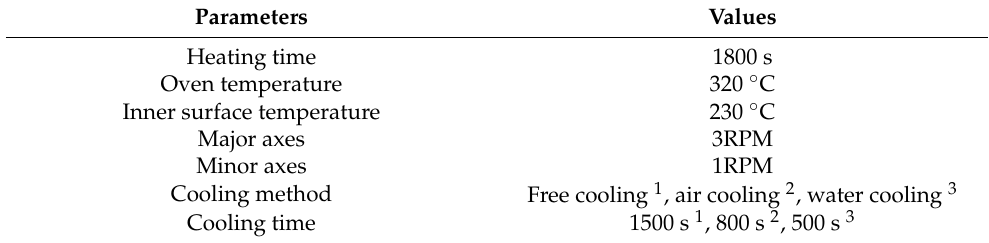
Figure 15. The polymer liner rotational molding specimen. Table 5. Rotational molding